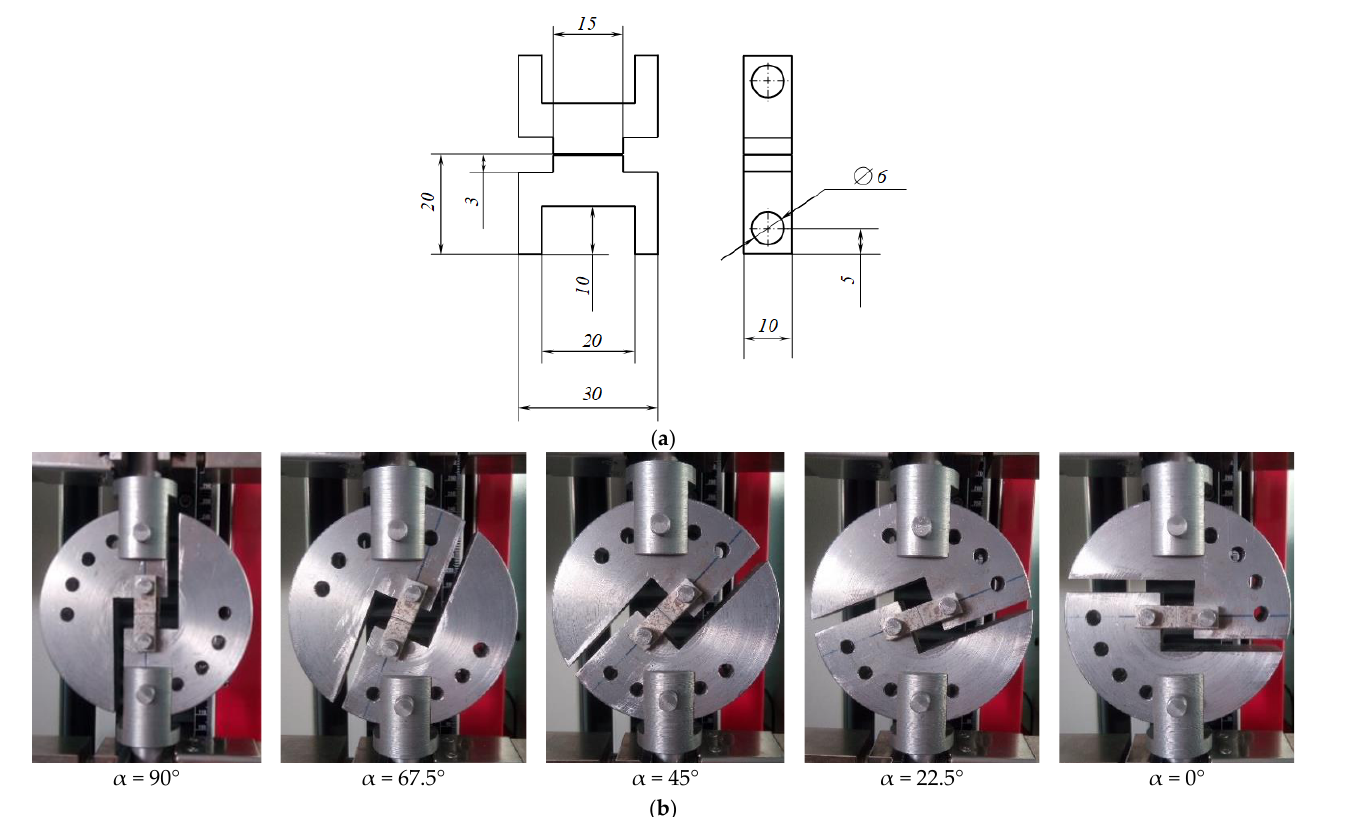
Figure 3. Modified Arcan specimens: an insert from the bonded assembly, dimensioned in mm ( a ); the specimens in the testing machine grips, with different orientation relative to the tensile axis ( b ).